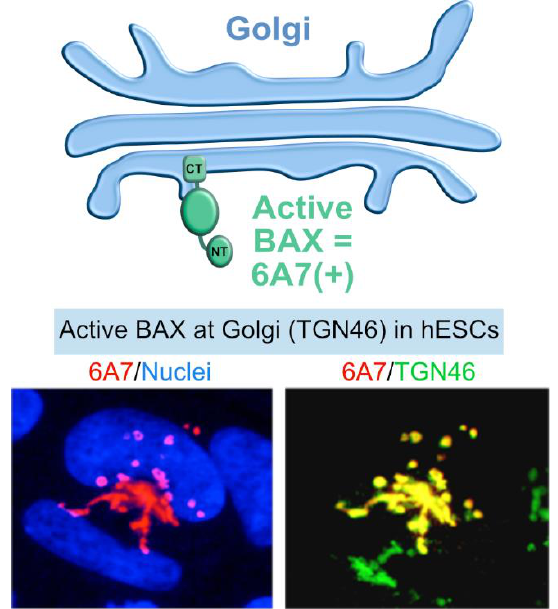
FIGURE 3: BAX activation in stem cells. Besides high mitochon- drial priming, human ESCs also have an active form of BAX at the Golgi that rapidly translocates to the mitochondria under apop- tosis stimuli. Active form of BAX: BAX 6A7; Golgi apparatus marker: